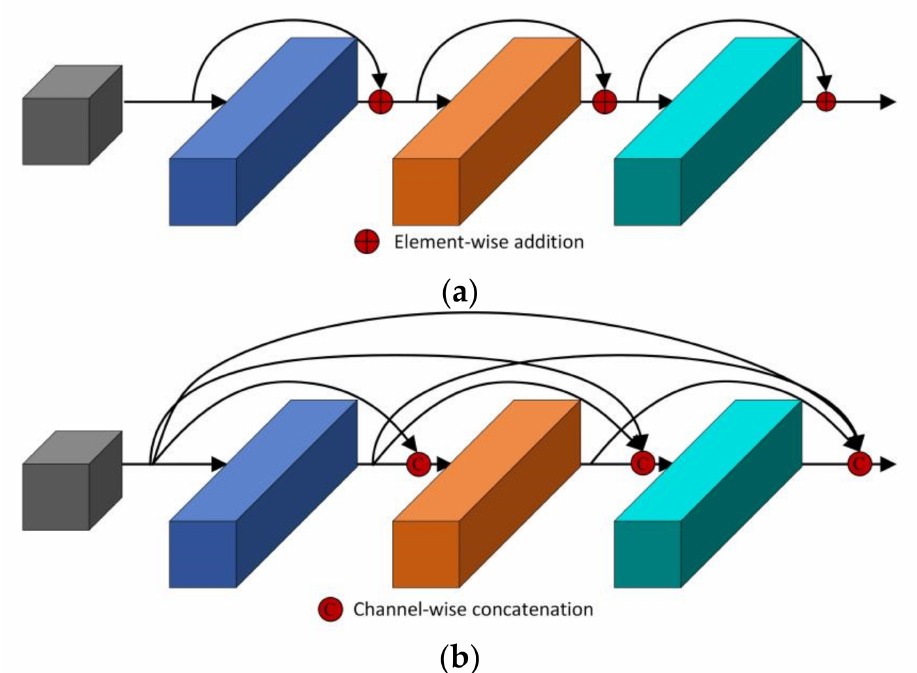
Figure 1. Flowcharts of ResNet and DenseNet. ( a ) ResNet, ( b )